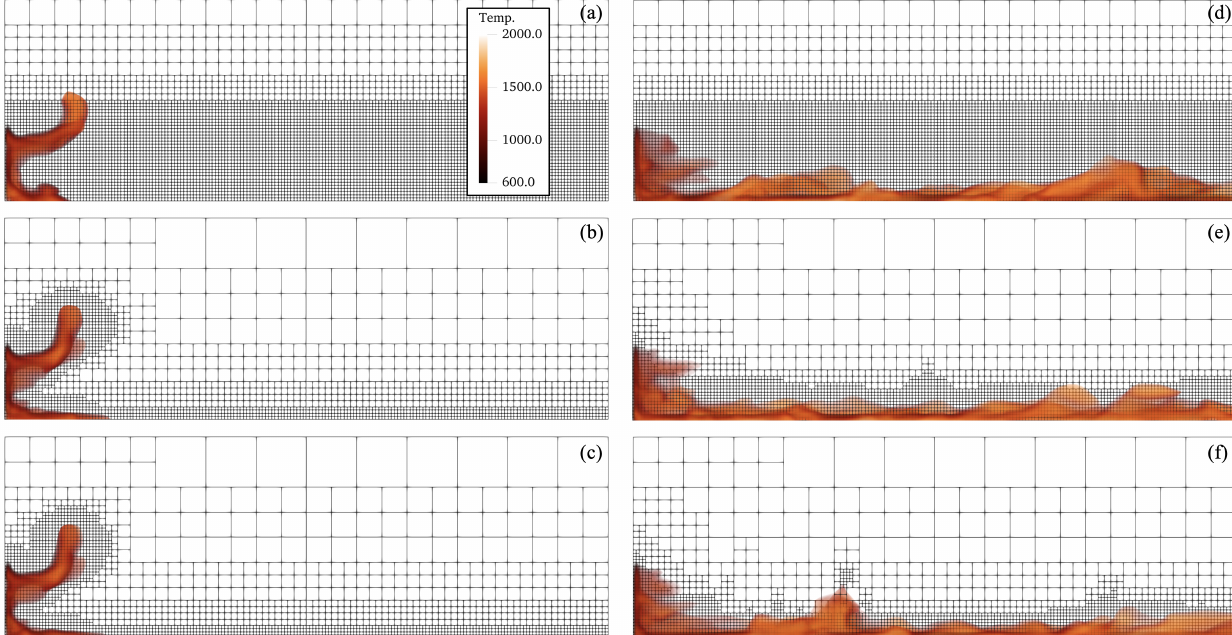
Figure 2. Visualization of static, AMR, and balanced AMR verification cases. The gas phase is visualized using volume renders of regions with high HRR for static ( a , d ), for AMR without load balancing ( b , e ), and AMR with load balancing ( c , f ) vertical panel spread cases at times 1.0 s (a–c) and 5.0 s (d–f). Regions are colored by temperature from low (black) to high (yellow). The computational meshes are visualized in a plane through the center of the domain in each